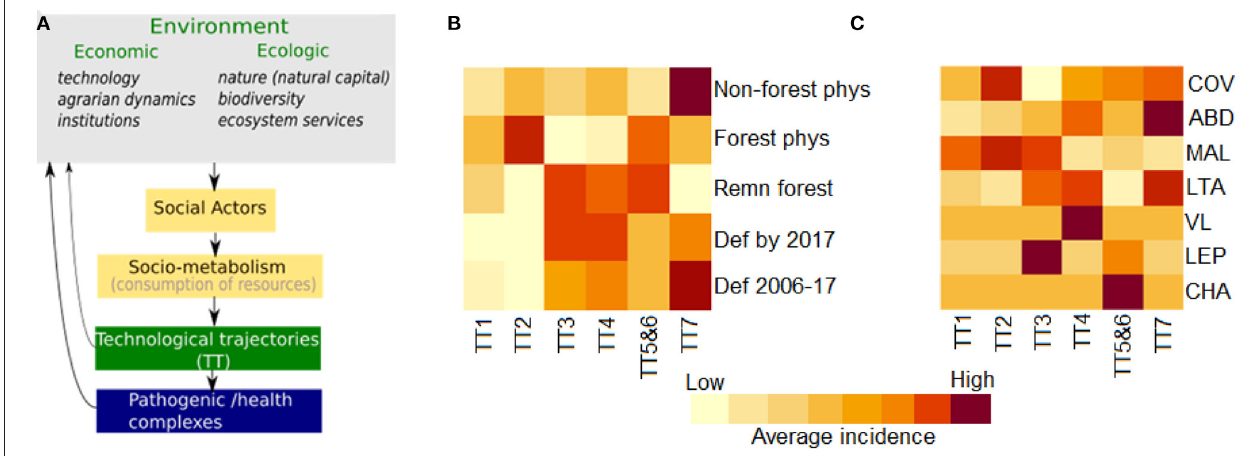
FIGURE 3 | Theoretical model for the system comprising the technological, ecological and epidemiological trajectories in the Amazon region. (A) Diagram presenting links between economic and ecological context variables and pathogenic/health complexes mediated by the technological trajectories. (B) Heatmap of the median environmental and disease indicators in municipalities following different technological trajectories (see Table 1 for trajectory description, TT-1 to TT-7). Ecological indicators: recent deforestation (def 2006-2017); total deforestion prior to 2017 (Def by 2017); amount of forest remnant areas in 2017) (remn forest); forest physiognomy as the original biome (forest phys); non-forest physiognomy-savanah, rocks, natural grassland and wetland (non-forest phys). (C) Median disease incidence in municipalities following the assessed technological trajectories: schistosomiasis (SCH), leptospirosis (LEP), Chagas disease (CHA), visceral leishmaniasis (VLE), malaria (MAL), american cutaneous leishmasis (ACL), Aedes -borne diseases (ARB), COVID-19